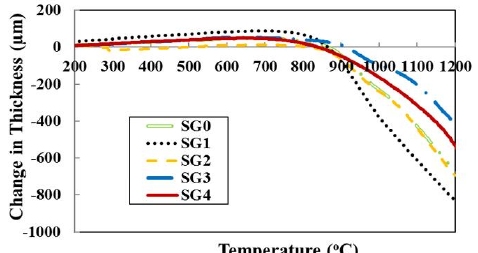
Figure 3. Thermo ‐ mechanical analysis (TMA) results for whole coal and density fractions of Pittsburgh No. 8 seam coal.